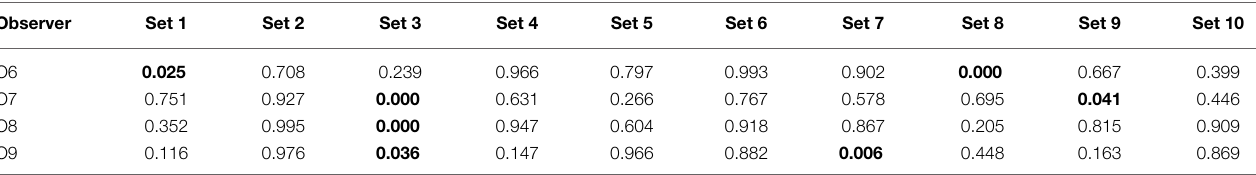
TABLE 1 | P -values of χ 2 - test (9 degrees of freedom) with the null hypothesis that the performance of a given observer is the same as the mean performance of 3 other observers. Observer Set 1